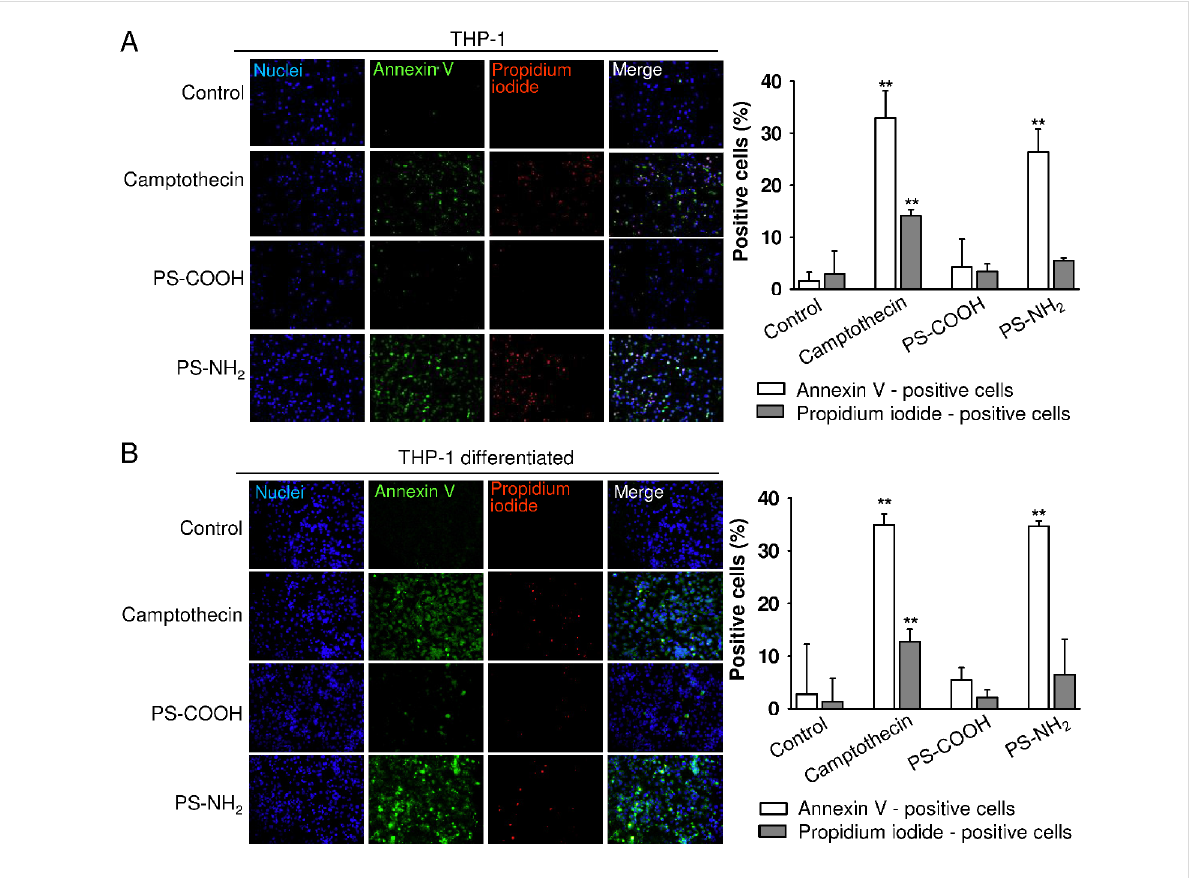
Figure 4: Amino-functionalized polystyrene nanoparticles induce apoptotic cell death. THP-1 (A) and differentiated THP-1 (B) were stimulated with either PS-COOH or PS-NH 2 (each at 100 µg/mL) for 72 h, analyzed by using fluorescence microscopy and quantified by using ImageJ. The graphs show the amounts of apoptotic (annexin V + ) and late apoptotic or necrotic (propidium iodide + ) cells. Camptothecin: positive control. Results are mean ± SEM, n = 3, ** p < 0.01.